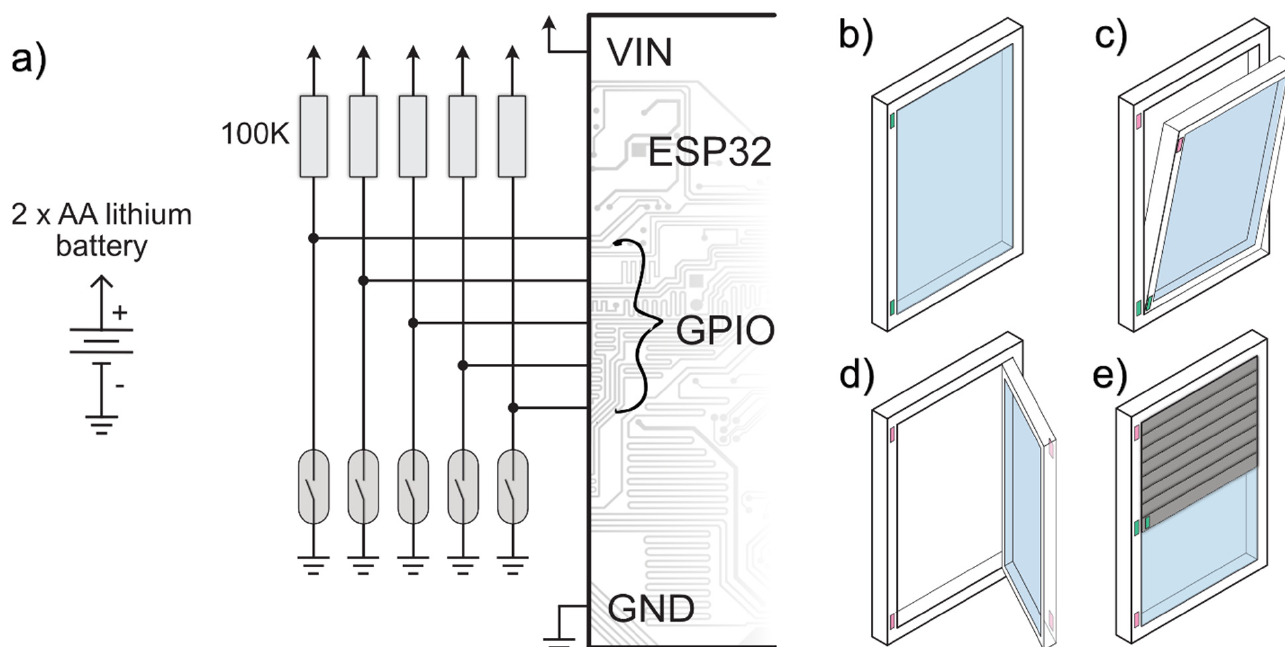
Figure 5. ( a ) Window module schematic diagram; ( b ) closed window from inside showing the position of reed switches and both are closed; ( c ) tilted window from inside, bottom reed switch is closed; ( d ) fully open window from inside, both reed switches are open; ( e ) position of the reed switches recording shutter position from external side, middle is closed, showing the shutter is half closed.